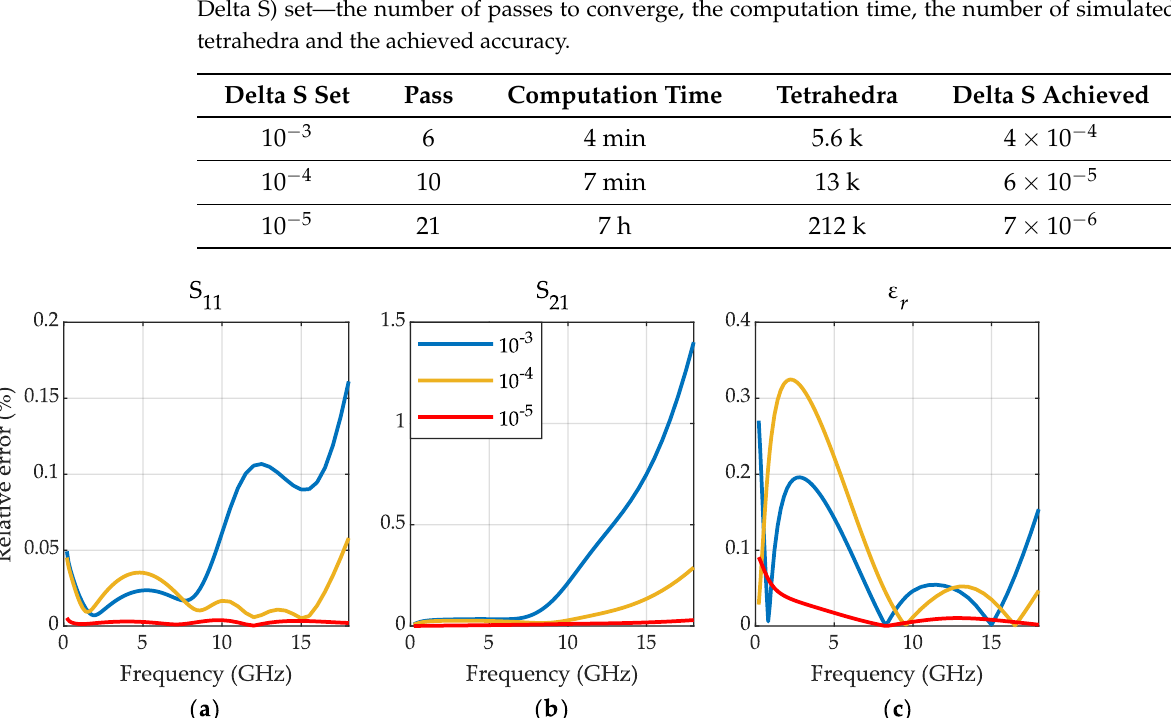
Figure 5. The relative error of ( a ) S 11 , ( b ) S 21 and ( c ) ε r for the line filled with 2 mm column of water for the different values of the accuracy represented by the parameter Delta S